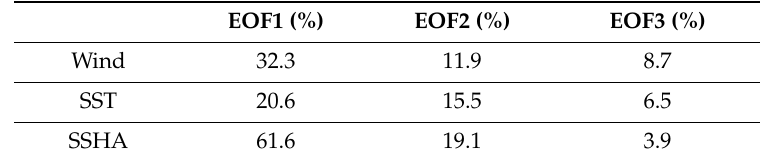
Table 1. Spatio-temporal EOF variances accounted for by the first three modes of wind, sea surface temperature (SST), and sea surface height anomalies (SSHAs).